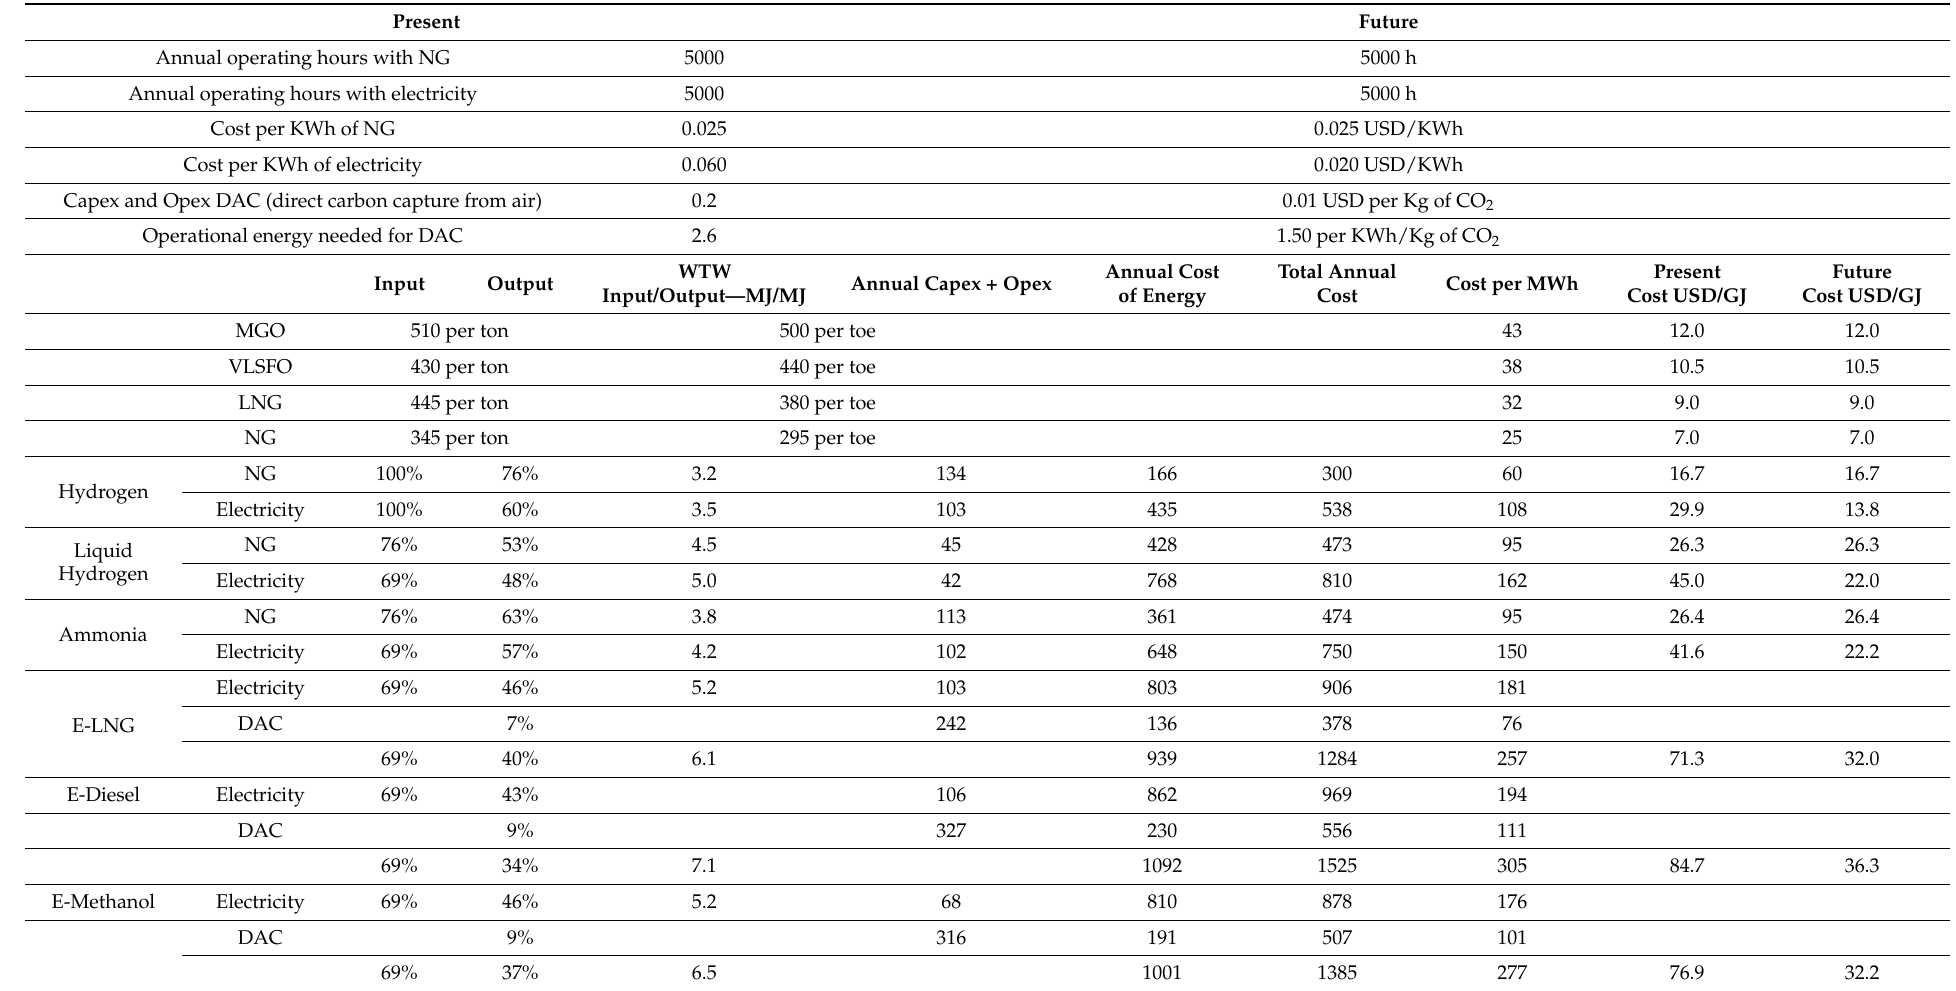
Table 3. Marine fuel price predictions from Lindstad